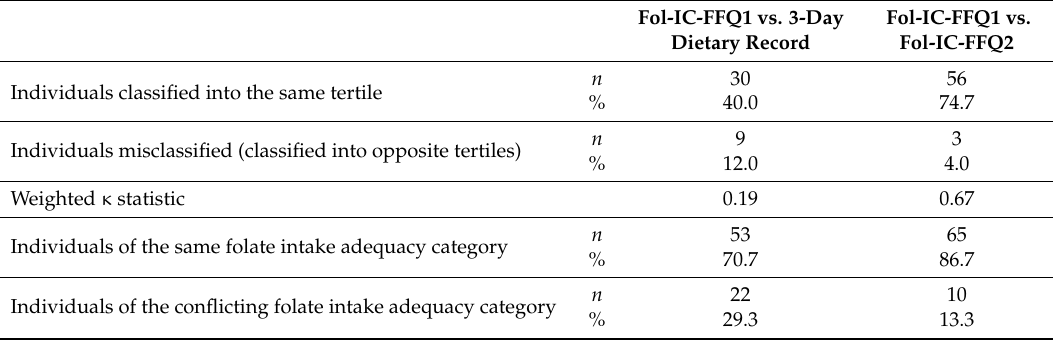
Table 4. The number and share of individuals classified into the same tertile and misclassified, as well as individuals of the same or conflicting folate intake adequacy category in comparison of Fol ‐ IC ‐ FFQ and 3 ‐ day dietary record.